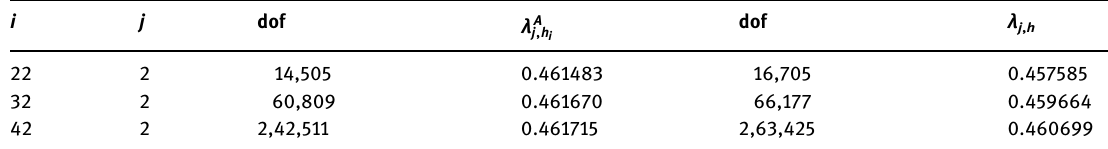
Table 3: The second eigenvalue for ( 2.1 ) – ( 2.2 ) : the square with a slit ( k = 1, n ( x ) = 4 )